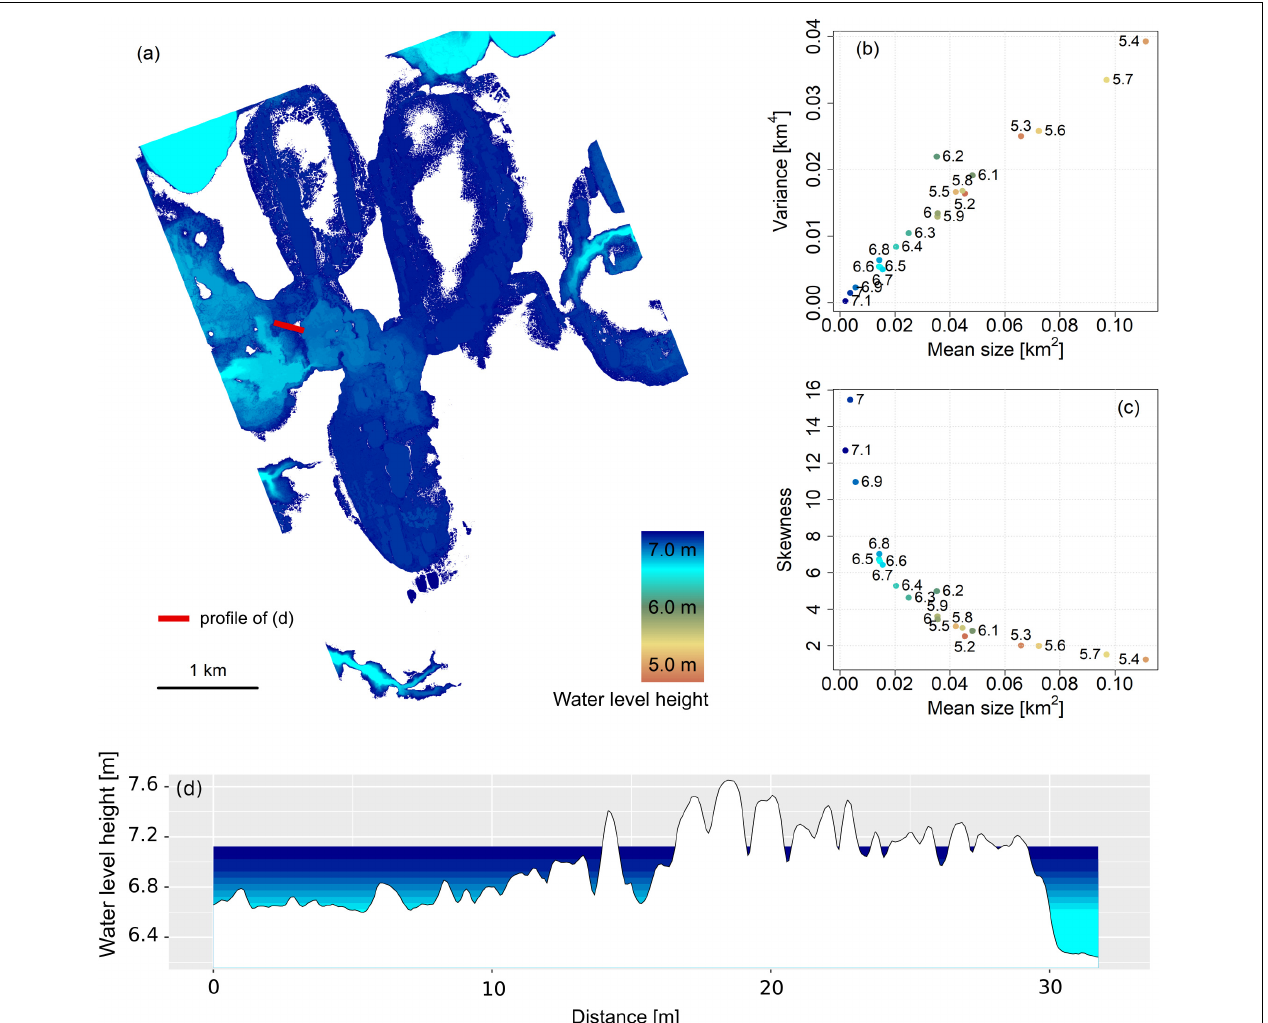
FIGURE 9 | Synthetic waterbody map, together with statistical moments for the waterbody size distributions, for the Fish Creek catchment area, Alaska. (a) Synthetic waterbody map; different colors indicate the different water levels at which waterbodies were extracted. Plots of the variance (b) and skewness (c) of waterbody size distributions versus mean waterbody size: the point colors correspond to the colors on the map and the labels refer to the surface water levels in meters above sea level. Those DEM pixels elevations lower than or equal to the chosen water level were extracted and converted into a vector file. This method produced a series of waterbody maps with continuously growing and deepening waterbodies. The section (d) is a DEM profile that illustrates the increase in water level (red line on the map marks the position of the DEM